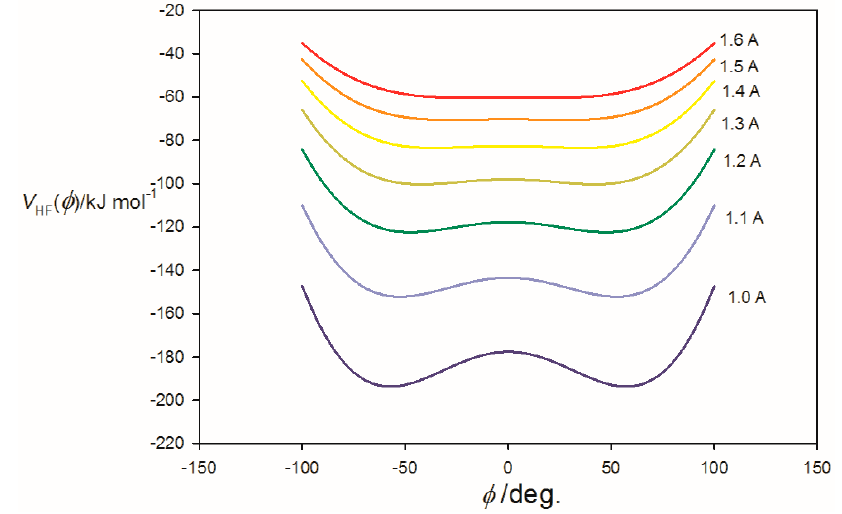
Figure 10. The electrostatic potential energy V HF ( φ ) of HF treated as a simple extended electric dipole